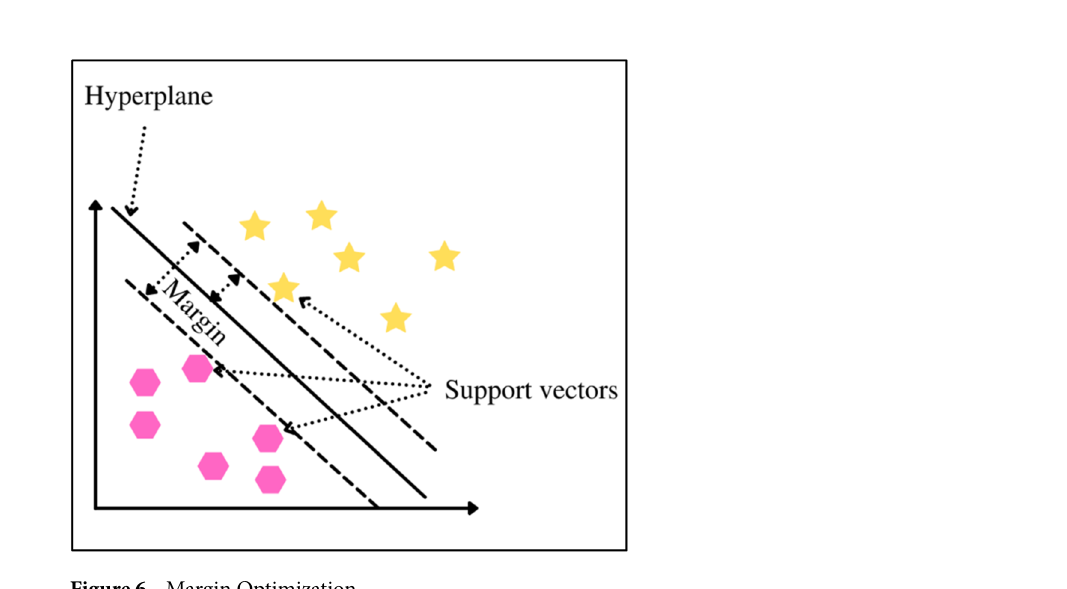
Figure 6. Margin